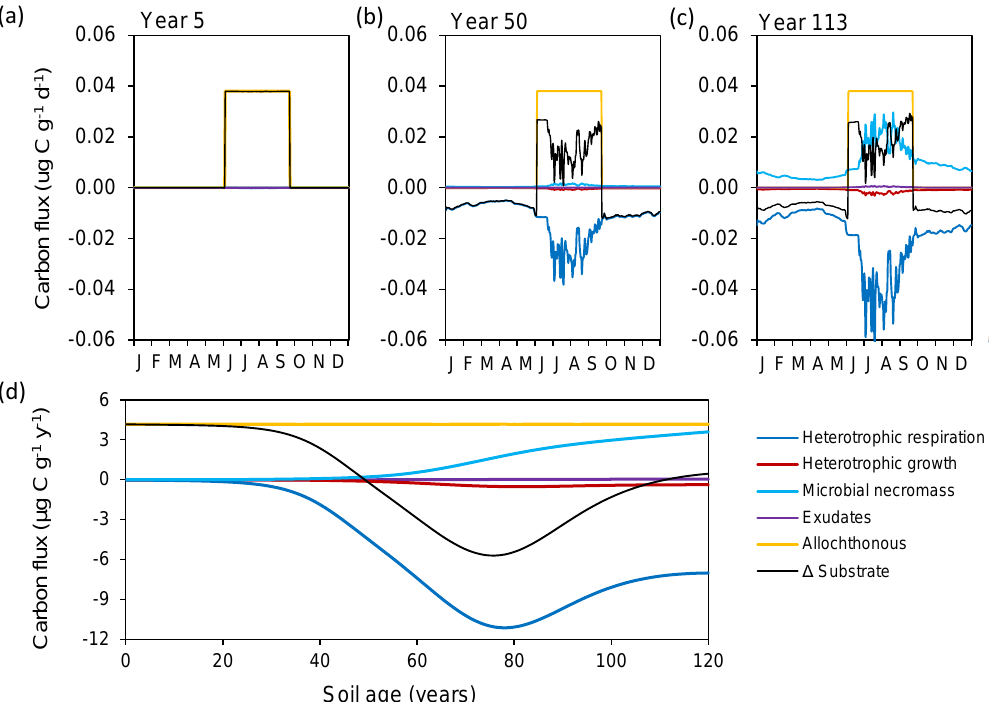
Figure 5. Illustration of daily carbon fluxes for (a) 5-, (b) 50-, and (c) 113-year-old soil, as well as (d) annual carbon flux over 120 years. Microbial necromass (light blue), exudates (purple), and allochthonous sources (yellow) contribute to the substrate pool (black), and het- erotrophic growth (red) and respiration (dark blue) deplete